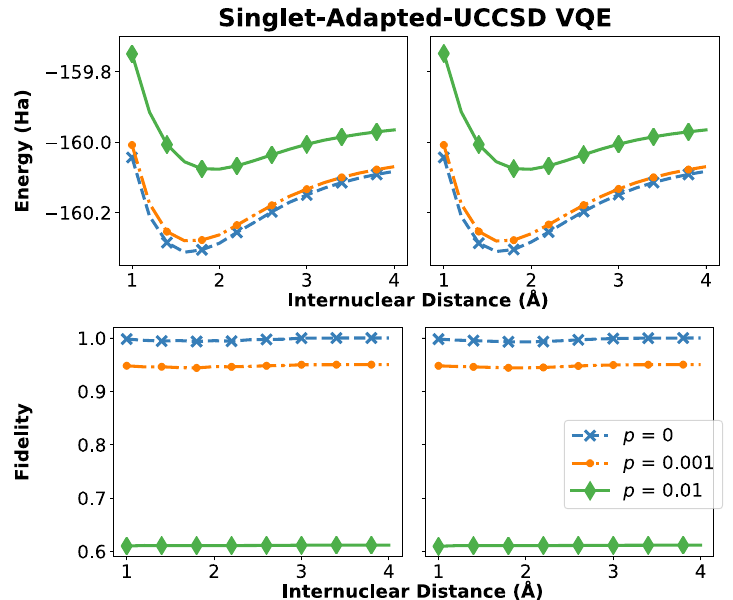
Fig.6 The top row presents the ground state electronic energy of NaH using the Singlet-Adapated-UCCSD ansatz within the VQE method with different levels of depolarizing noise, p . The bottom row presents the corresponding fidelity of the prepared quantum state and that of the ground state found through conventional means. The left and right columns differentiate the results found using the COBYLA and L-BFGS optimizers,